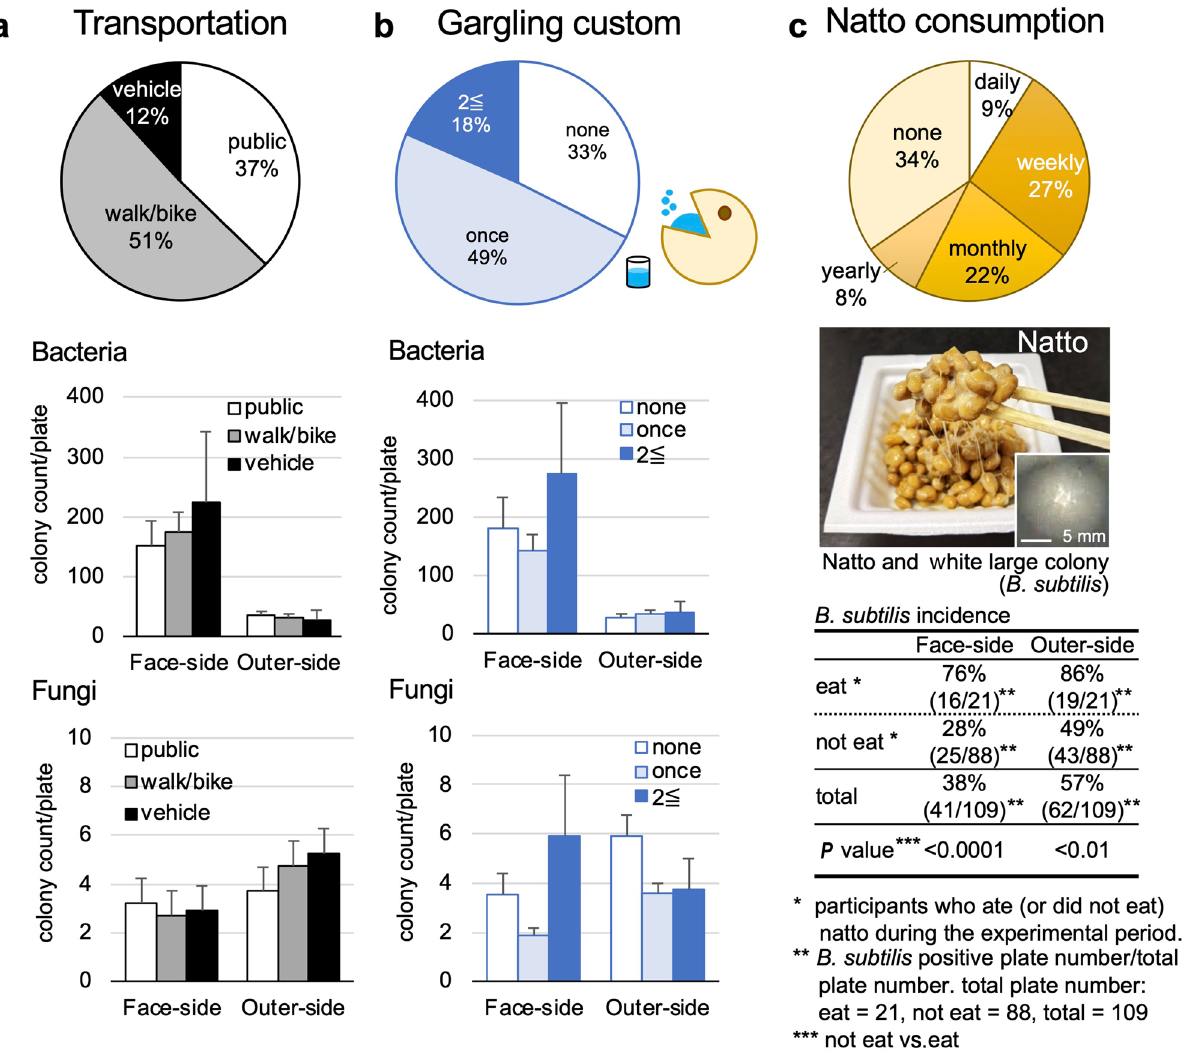
Figure 3. Lifestyles and microbial colonies: transportation, gargling, and natto consumption. ( a ) We categorized three transportation systems to commute: (1) public transportation: trains and/or buses; (2) private vehicles: cars and trucks; and (3) walk/bike: walking, bicycles, and motorbikes. We found no differences in the bacterial and fungal colony counts among the three transportation categories on the face-side or outer- side of masks. ( b ) Microbial colony counts and the gargling habit. The pie chart showed the percentage of participants’ gargling frequency; 67% of the participants gargled at least once a day. We found no differences in the bacterial or fungal colony counts among the participants regardless of the gargling frequency. ( c ) Natto consumption and Bacillus subtilis colonies. Natto is a traditional Japanese food made from soybeans fermented with B. subtilis that forms large white colonies on agar plates. According to the survey, 9% and 27% of the participants have eaten natto daily and weekly, respectively; 19% (21 of 109) of the participants ate natto during the experimental period. The participants who ate natto had a significantly higher percentage of B. subtilis colonies than those who did not eat large 10 mm <), color, and frequencies (Fig. 4a,b). The frequency of colonies was calculated in two formulas: (I) colony incidence = number of plates containing the colony of interest/total plate number (n = 109) × 100; and (II) % total = counts of colonies of interest/total counts of colonies in each plate × 100 (then, the mean of % total from all plates was calculated). As shown in Fig. 4a, most participants had more than one colony form. The dominance of the four colony forms regarding the colony incidence and mean % total of each colony was overall similar on the face-side and outer-side (Fig. 4b). The small white colonies were most frequently observed, with the inci- dence and % total exceeding 80% and 70%, respectively. To further determine the bacteria composing each colony, we conducted Gram staining and 16S ribosomal RNA (rRNA) sequencing. The 16S rRNA sequencing showed that the small white colonies consisted mainly of Staphylococcus epidermidis, and/or S. aureus ; the major bacteria species forming the small yellow colonies was S. aureus . The large white colonies were the second most observed ones and consisted of B. subtilis , a component of natto (as shown in Fig. 3c). The medium white colonies consisted of B. cereus and B. simplex ; B. cereus was